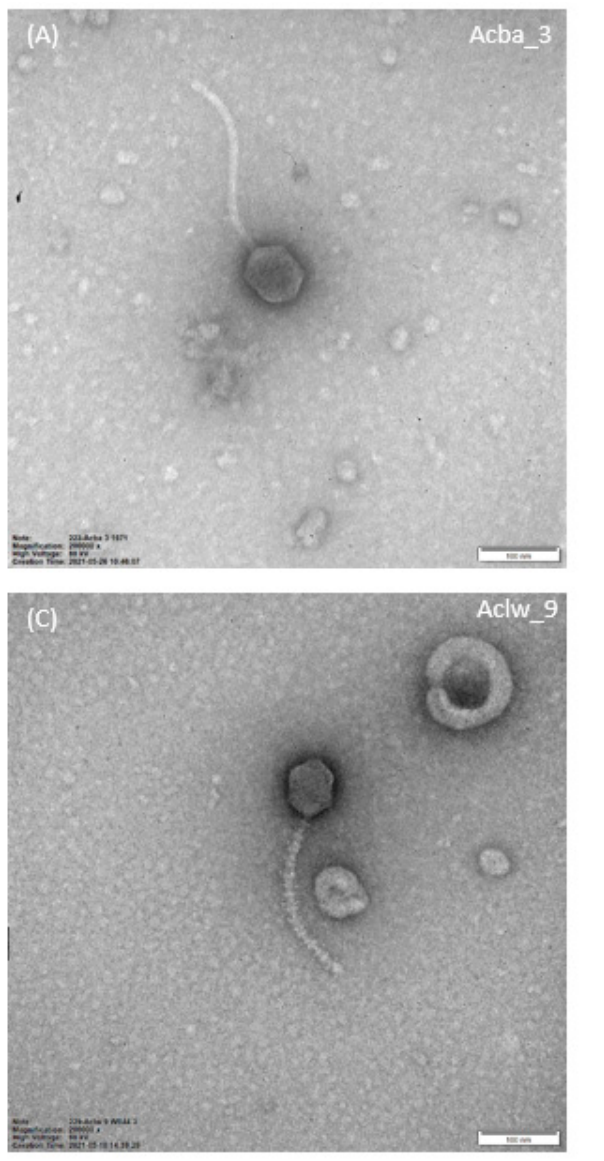
Figure 2. Electron micrographs from the TEM (Kodak/Carestream Electron Microscope) showing the morphology of selected bacteriophages. Panel ( A ): Acba_3, Panel ( B ): Acba_6, Panel ( C ): Aclw_9, Panel ( D ): Acba_16. The Acba_3, Aclw_9, and Acba_16 phages were photographed at a magnification of 200,000×, whereas the magnification for the Acba_6 phage was 250,000×. The reference bar shown on each panel corresponds to 100 nm. Table 3. The dimensions of the bacteriophages were determined based on the measurements of ten virions for each of 12 phages.